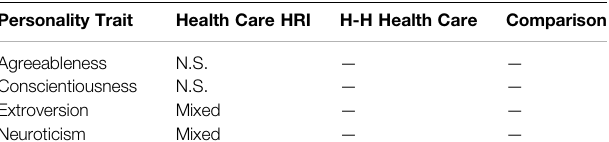
TABLE 9 | Comparison of human-human health care studies and H-HRI studies on personality. Patients ’ personality traits and health care performance outcomes Personality Trait Comparison